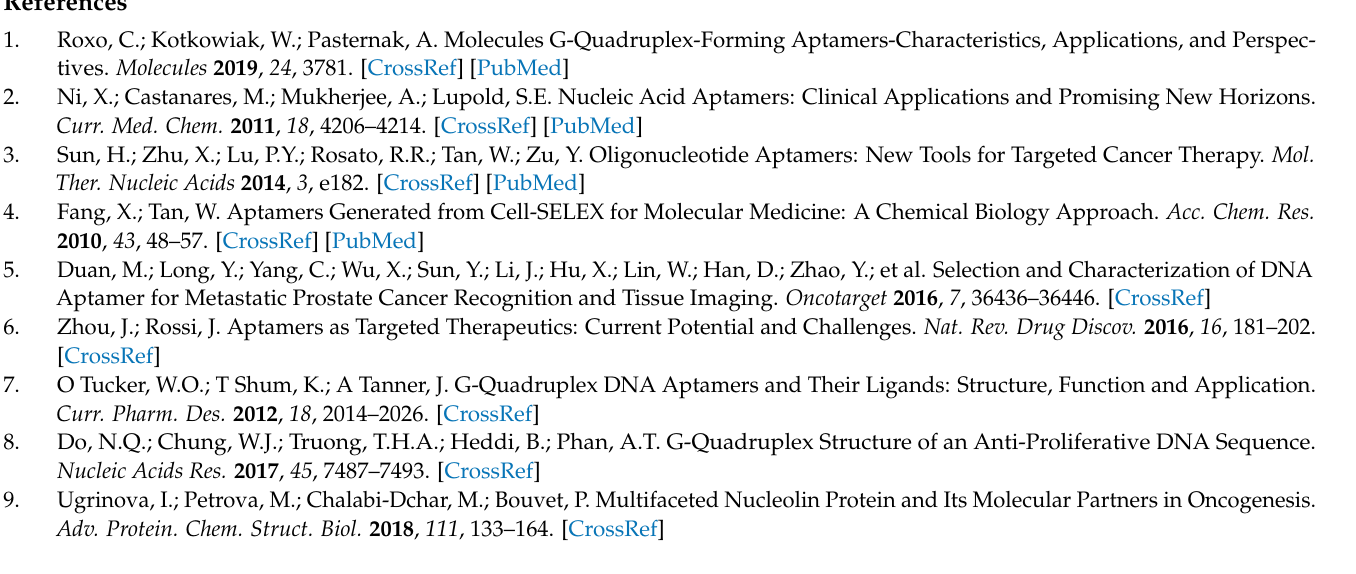
G4/PhenDC3 complex at 37 ◦ C. Figure S4-Fluorescence titration spectra of pre-folded 5 (cid:48) -Cy5-AT11-L2 sequence complexed with (A) 360A, (B) BRACO-19, (C) PhenDC3, (D) TMPyP4 and (E) PDS with increase concentrations of NCL. Figure S5. Predicted structure of AT11-L2 G4, obtained from the final snapshot of the 200 ns MD simulation. Nucleotides are highlighted in orange and the backbone is coloured in light grey. (A) Side view and (B) Top view. (C) RMSF plot of each nucleotide in the AT11-L2 G4 structure during the full 200 ns MD simulation. (D) RMSD plot of the 200 ns simulation of AT11-L2 G4 structure. Figure S6. Final snapshots (side and top view) and RMSD plots of 200 ns MD simulations of the complexes between AT11-L2 G4 and (A) BRACO-19, (B) 360A, (C) PDS and (D) TMPyP4. The backbone is highlighted in light grey, while nucleotides are depicted in orange. Potassium ions are shown in purple. The ligand is depicted in blue. Hydrogen bonds are depicted as dashed red lines. The first and last nucleotides of AT11-L2 are also shown. Table S1-NCL and 5 (cid:48) -FAM-AT11-L2-3 (cid:48) -TAMRA/PhenDC3 colocalization coefficients represented in mean ±